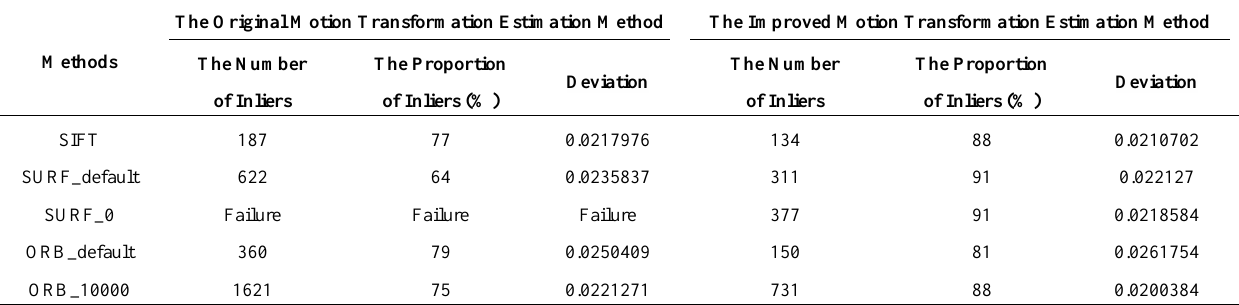
Table 5. Results for motion transformation estimation on 337th and 338th